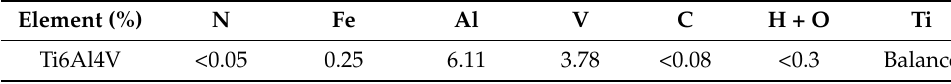
Table 1. Chemical compositions of Ti6Al4V samples (wt.%).